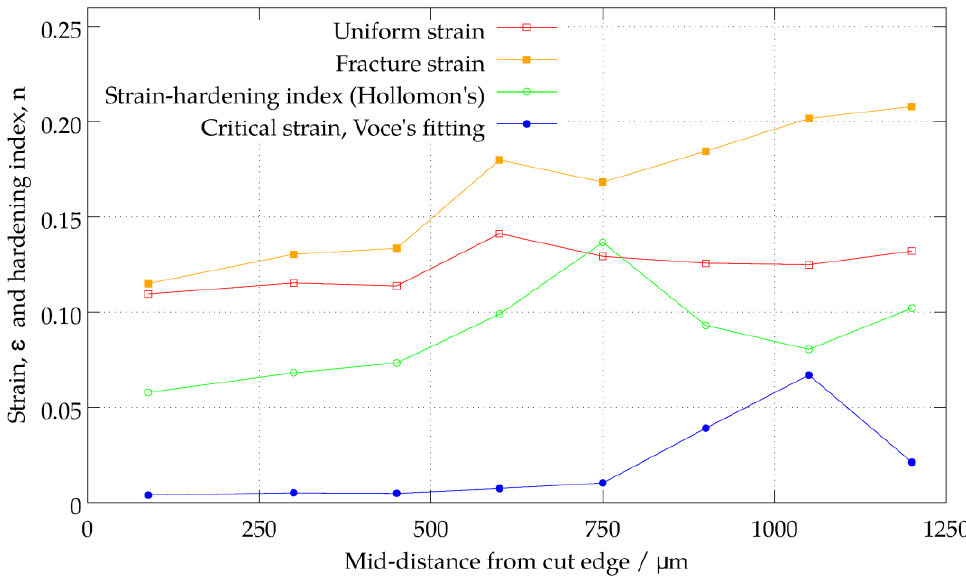
Figure 10. Evolution of the uniform strain, fracture strain, hardening index, and critical strain as a function of the distance to edge cut by plasma.